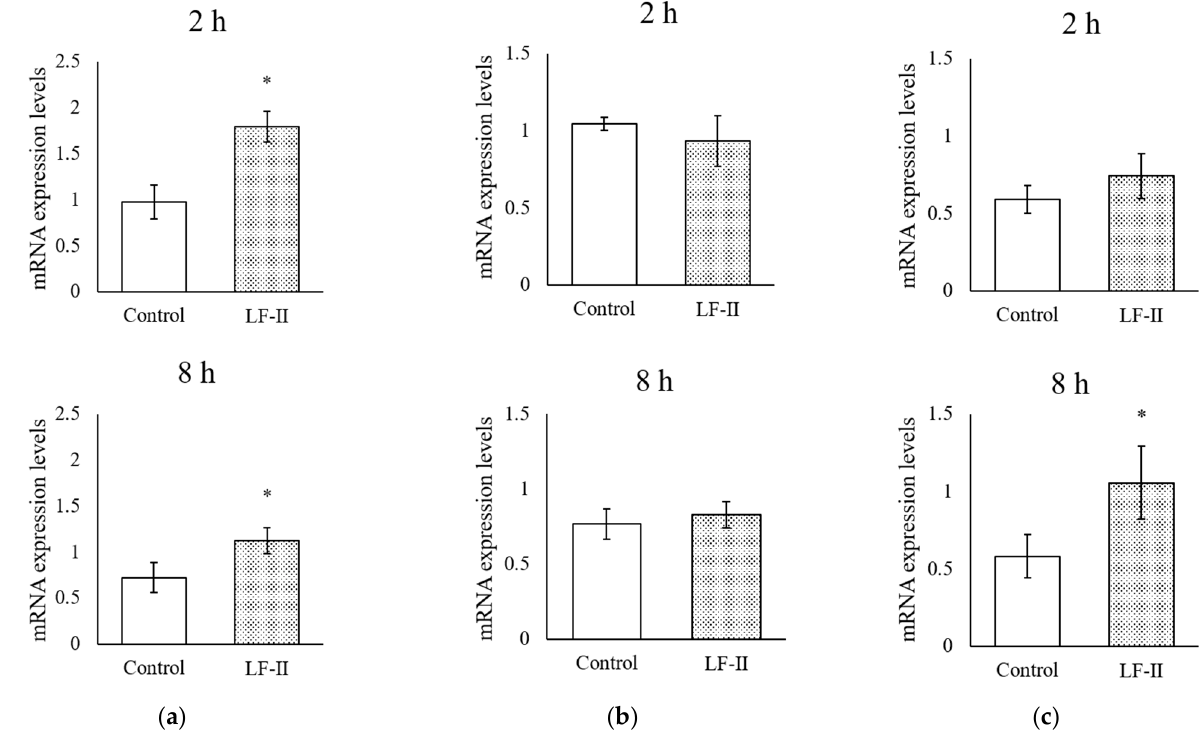
Figure 6. Real-time quantitative PCR measuring mRNA expression levels of bone differentiation and calcification markers, ( a ) osteocalcin , ( b ) runx2 , and ( c ) osterix , after LF-II treatment with ascorbic acid (50 μ g/mL) and β -GP (10 mM) for 1 week. Total RNA was isolated 2 or 8 h after HA treatment. Data are presented as means ± SD; * p < 0.05, compared with the control. LF, lactoferrin.